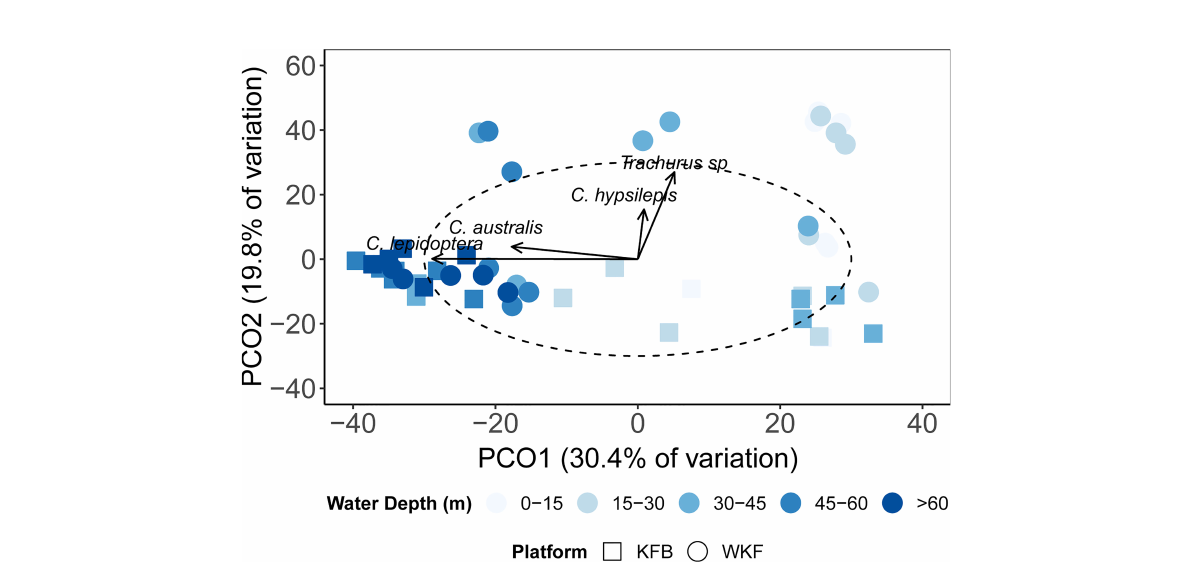
FIGURE 10 Principal Coordinates Analysis (PCO) showing multivariate fi sh data (fourth-root transformed) at the two platforms surveyed (KFB- squares, WKF- circles), according to the fi ve depth bands selected. Arrows represent fi sh species showing signi fi cant correlation (|R| ≥ 0.4) with the PCO